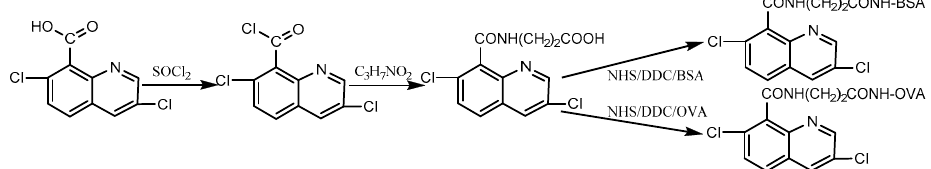
Figure 1. The preparation route of the quinclorac hapten and artificial antigen.